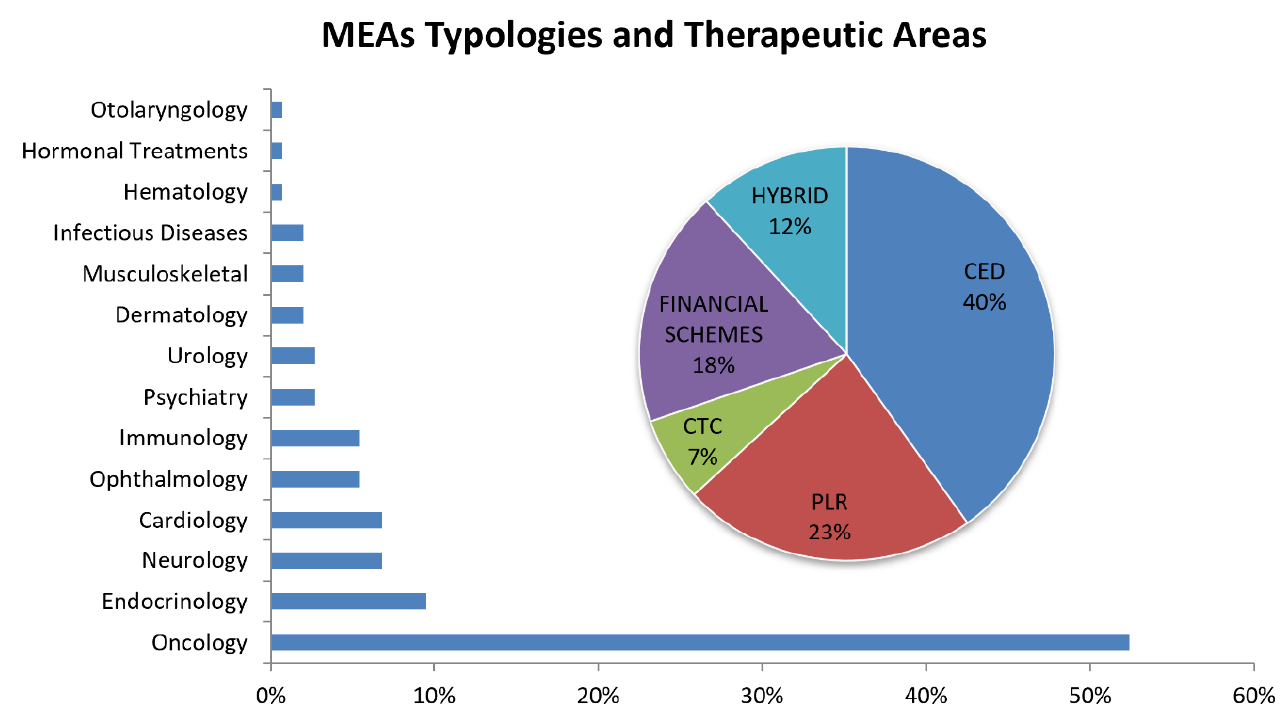
Figure 7. Bars chart: Percentage of arrangements developed in different therapeutic areas. Pie chart: Percentage of performance-based arrangements in 2013. CED: coverage with evidence development; CTC: conditional treatment continuation; PLR: performance-linked reimbursement.